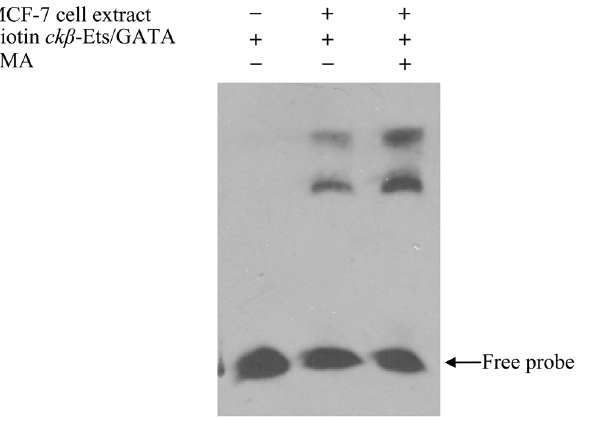
Figure 9. Effect of PMA on the binding of Ets and GATA to the ck b distal promoter. EMSA was performed using nuclear extracts from MCF-7 cells treated with or without 20 ng/mL PMA. The blot is representative of three independent experiments that produced similar